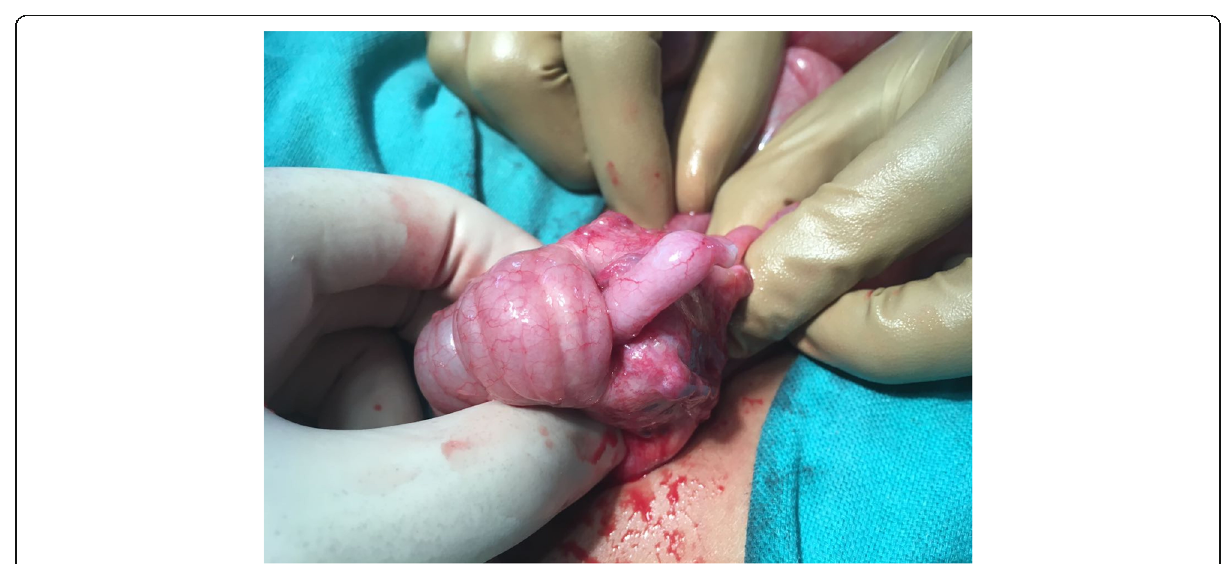
Fig. 1 Patient A with appendicocecal